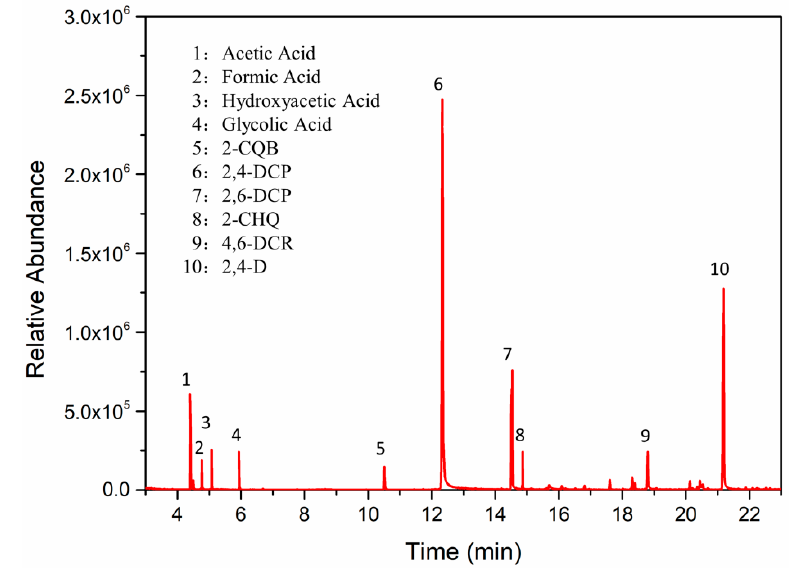
Figure 11. GC-MS spectra of intermediate products formed in 2,4-D degradation ([2,4-D] 0 = 5.0 mg/L, [Fe 0 @Fe 3 O 4 ] 0 = 0.5 g/L, H 2 O 2 = 1 mM, pH = 5.0 ± 0.2, T = 30 °C). 2-CBQ, 2-chloro-1,4-dichlorobenzoquinone; 2,4-DCP, 2,4-dichlorophenol; 4,6-DCR, 4,6-dichlororesorcinol.